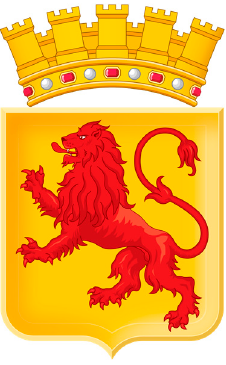
Figure 13. Government proposal, 2014.